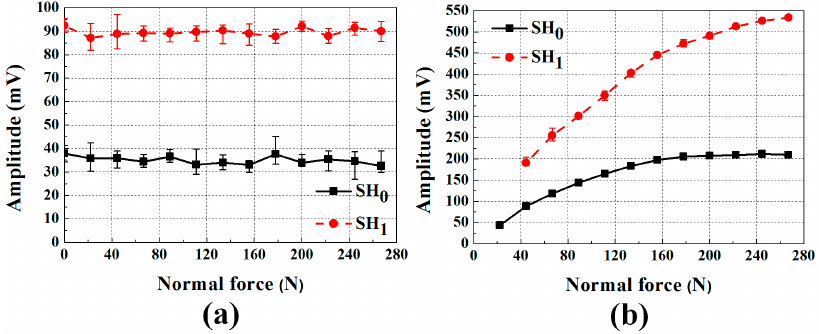
Figure 10. The averaged peak amplitudes of each mode for: ( a ) EMATs; and ( b ) MSTs as a function of the applied normal force. The EMATs are independent on the normal force, while the MSTs are not.